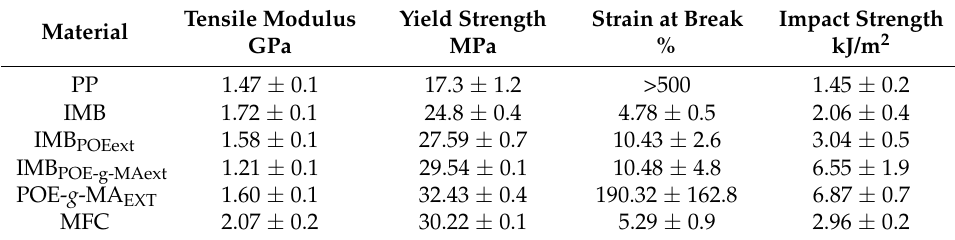
Table 5. Mechanical properties of injection moulding